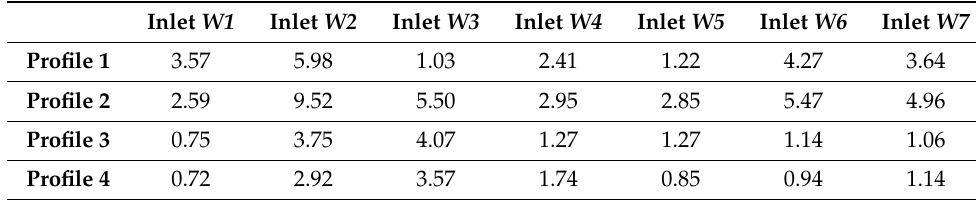
Table 3. Average stratification number ( Str